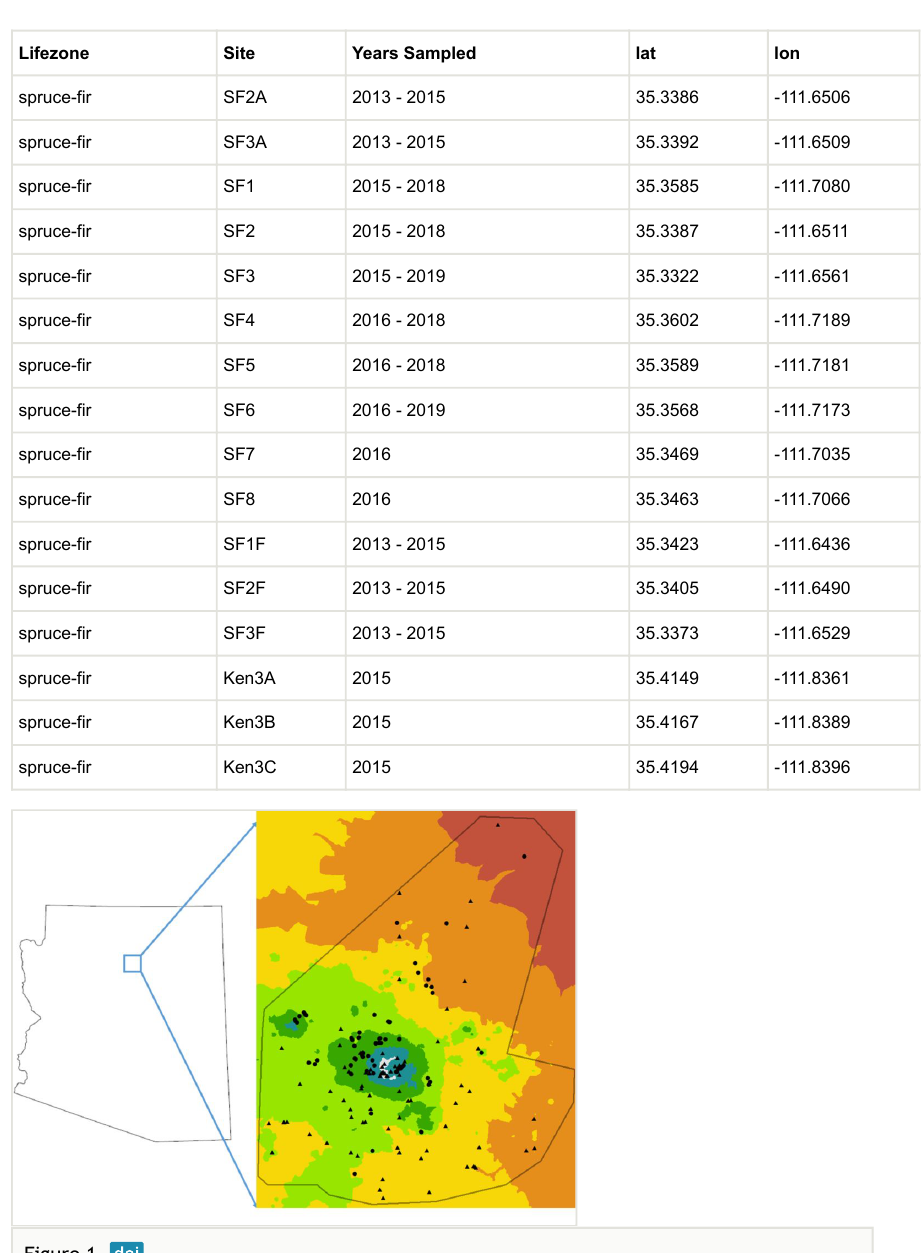
Figure 1. Map of collection instances on the San Francisco Peaks with life zones coded by color (dark red = desert shrub, orange = desert grassland, yellow = pinyon-juniper, green = ponderosa pine, dark green = mixed conifer, blue = spruce-fir and white = alpine). Black dots indicate our 58 survey plots from 2009–2019. Black triangles represent any unique collection instance gathered through SCAN, GBIF &